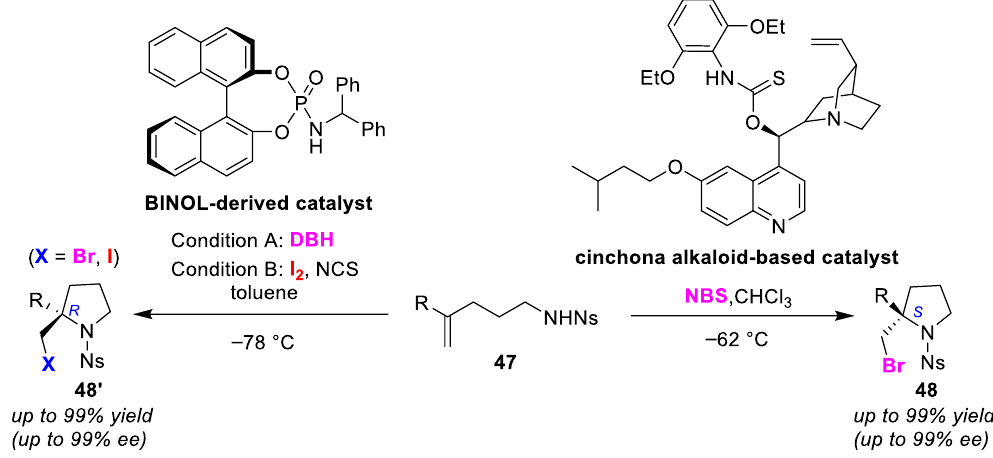
Figure 24. Enantioselective halo-cyclo-amination reaction of olefinic amines 47 using a cinchona alkaloid-based catalyst and BINOL-derived catalyst.